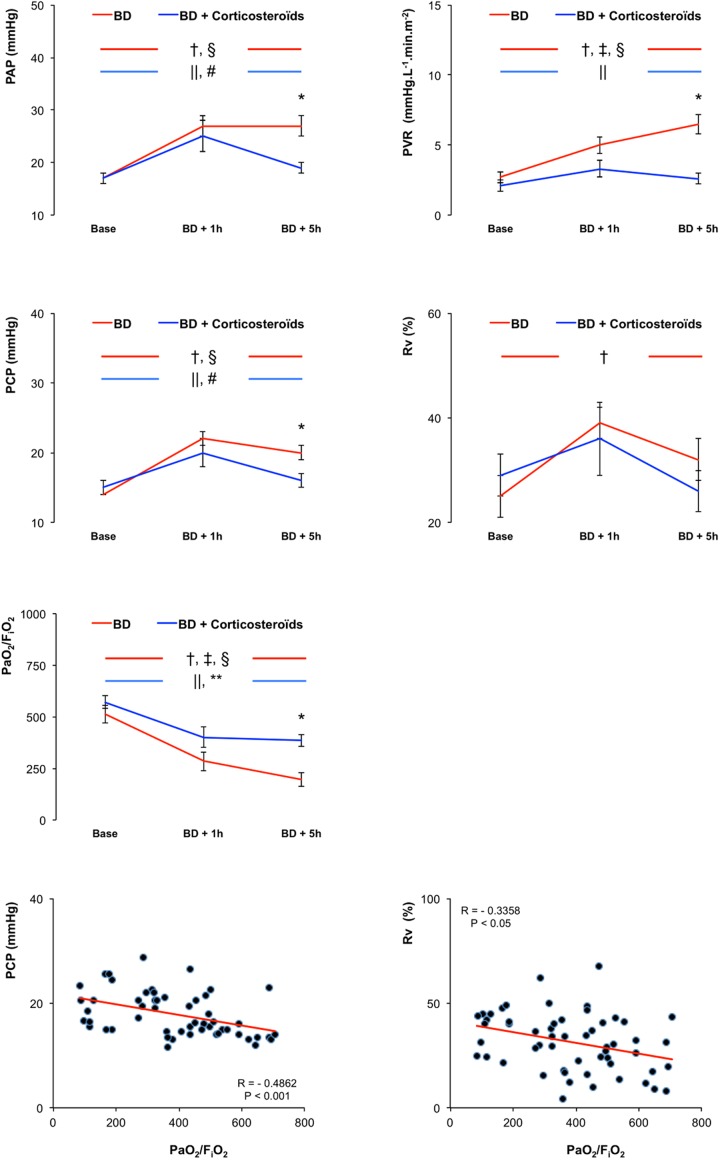
Hemodynamic evaluation.Mean pulmonary artery pressure (PAP), pulmonary vascular resistance (PVR), pulmonary capillary pressure (PCP), venous compartmental resistance (Rv), arterial PO2 divided by the fraction of inspired O2 (PaO2/FiO2) in pigs 1 hour and 5 hours after brain death (BD), with placebo-pretreatment (BD group, in red) or with preventive methylprednisolone (BD + Corticosteroids group, in blue) and correlation between PCP or Rv and arterial PO2 divided by the fraction of inspired O2 (PaO2/FiO2). Values are expressed as mean ± SEM. * p<0.05 BD versus BD + Corticosteroids; † p<0.05 Base versus BD + 1 hour, ‡ p<0.05 BD + 1 hour versus BD + 5 hours, § p<0.05 Base versus BD + 5 hours in the BD group; || p<0.05 Base versus BD + 1 hour, # p<0.05 BD + 1 hour versus BD + 5 hours, ** p<0.05 Base versus BD + 5 hours in the BD + Corticosteroids group.